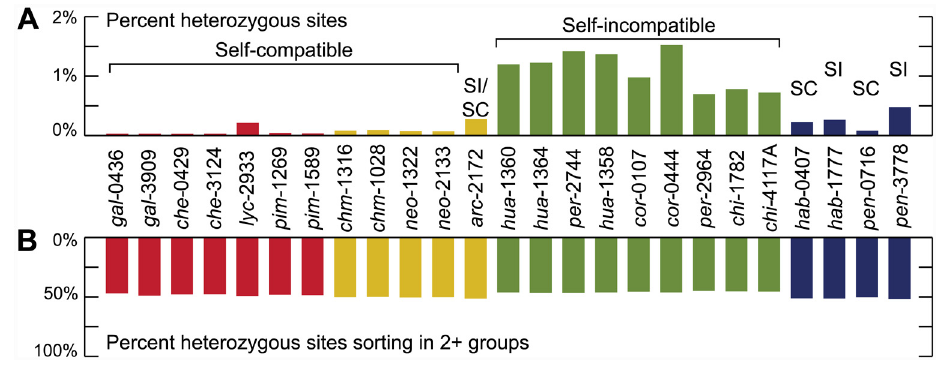
Fig 3. Low variation and pervasive sorting of ancestral heterozygosity in the wild tomato clade. (A) The fraction of heterozygous sites within accessions and (B) the proportion of heterozygous sites in each accession that are sorting in other